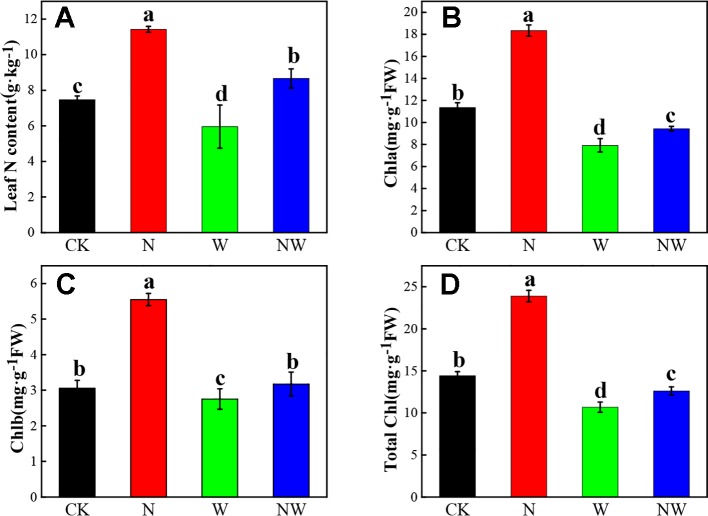
Effect of warming and N deposition on Leaf N and chlorophyll content of L. secalinus. Vertical bars represent ± SE of the mean, and different letters on the SE bars indicate significant differences among all treatments (P < 0.05). (A) Leaf N content (B) Chla (C) Chlb (D) total Chl. Each treatment has three replicated plots, and nine leaves from nine L. secalinus with similar growth status were chosen in each plot as a biological replication for analysis (3 biological replicates were performed).